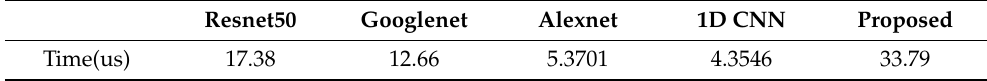
Table 7. The performance evaluation based on prediction time for one